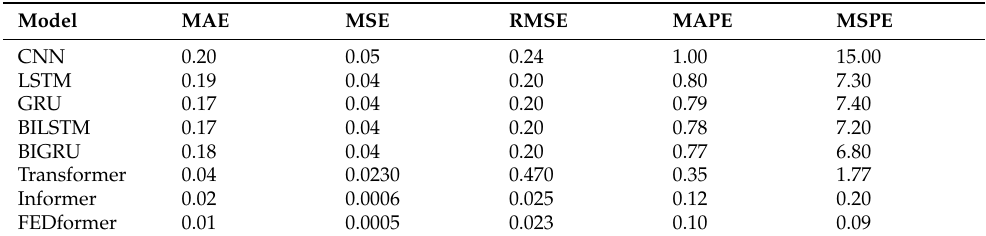
Table 3. Comparative experimental results on the performance of a model for predicting quality changes during maize storage.